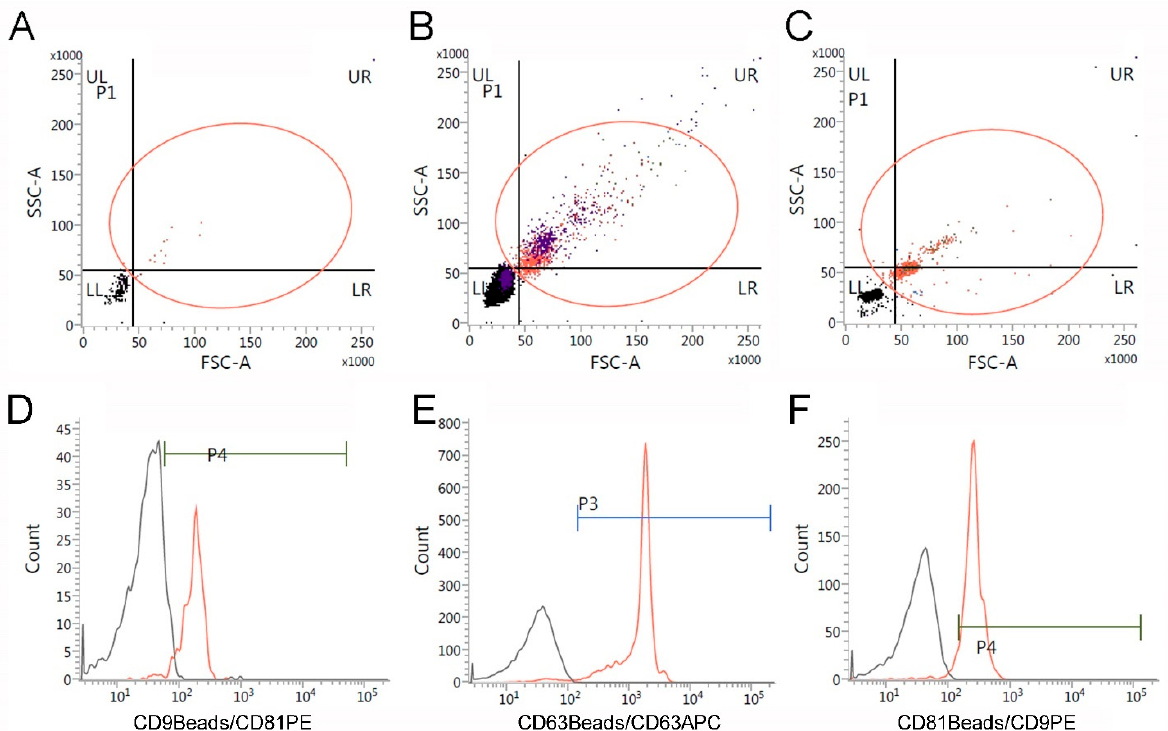
Figure 1. Flow cytometric characterization of extracellular vesicles isolated from adipose-derived mesenchymal stromal/stem cells (ASCs). ( A ) Flow cytometric measurement of PBS as a control with gating strategy. ( B ) Flow cytometric measurement of commercially available Dynabeads M-280 with 2.8 µ m diameter to calibrate the measurements. ( C ) Characteristic measurement of the Flow Detection Reagent Kit using magnetic Dynabeads with 2.7 µ m diameter. ( D – F ) Characterization of EVs with Flow Detection Reagent Kits using conjugated magnetic Dynabeads in combination with conjugated detection antibodies. As controls for the fluorescent measurements, bead-conjugated-EV solutions without detection antibodies were measured. All samples were measured using a flow cytometer (BD Biosciences, Heidelberg, Germany).